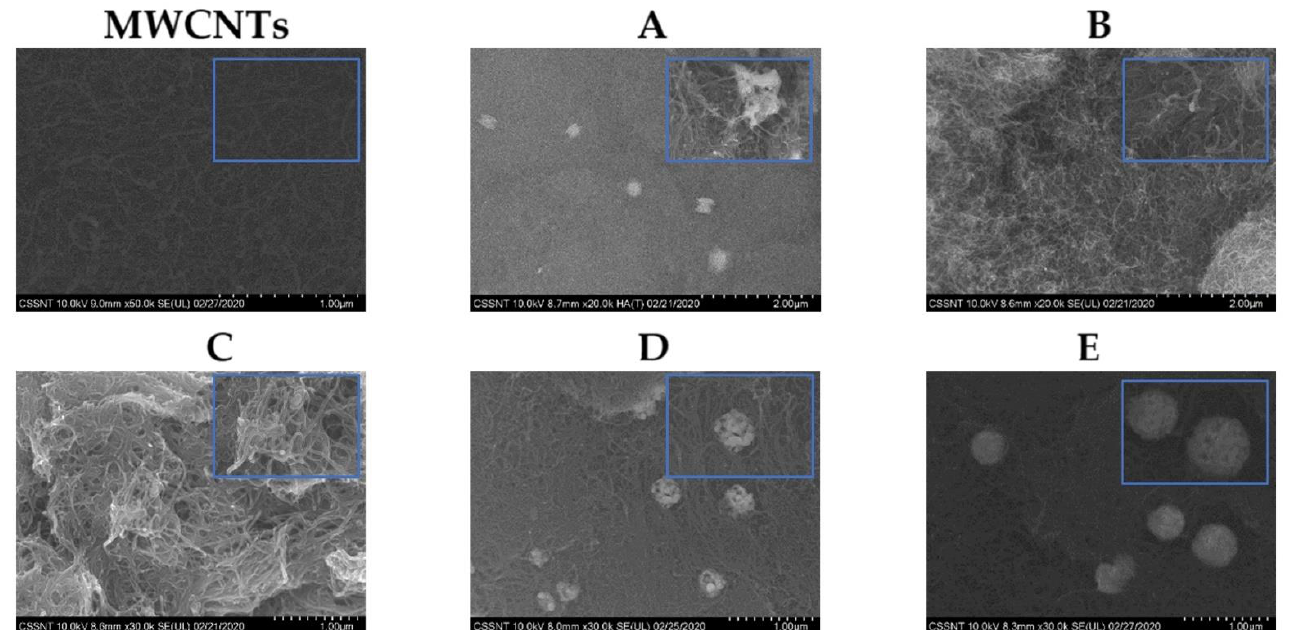
Figure 1. Electron microscopy images showing the structure of MWCNTs and AgMWCNTs samples ( A – E ) at different magnifications (20 × and 100 × (inset)).